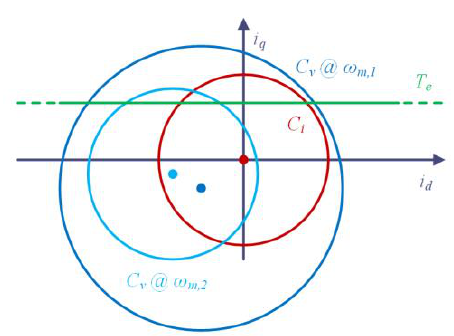
Figure 7. Current limitation (red), voltage saturation (blue), and torque locus (green) at different speeds ( ω m,1 < ω m,2 ).